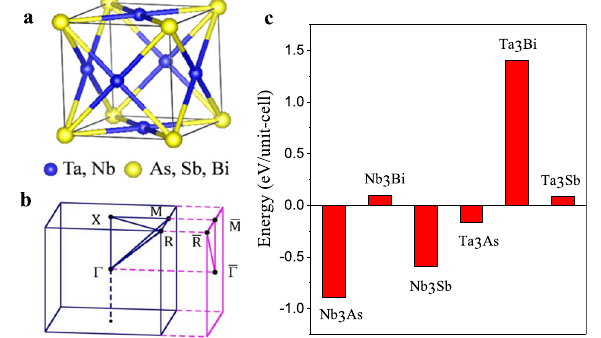
Fig. 1 Crystal structure. a The atomic structure of the L12 phase X 3 Y (X = Ta, Nb; Y = As, Sb, Bi) family compounds. Blue and yellow spheres denote the X and Y atoms, respectively. b The bulk Brillouin zone (BZ) and the projected BZ on the (010) surface. c The formation enthalpies ( Δ H ) of different X 3 Y compounds. The unit is eV per unit-